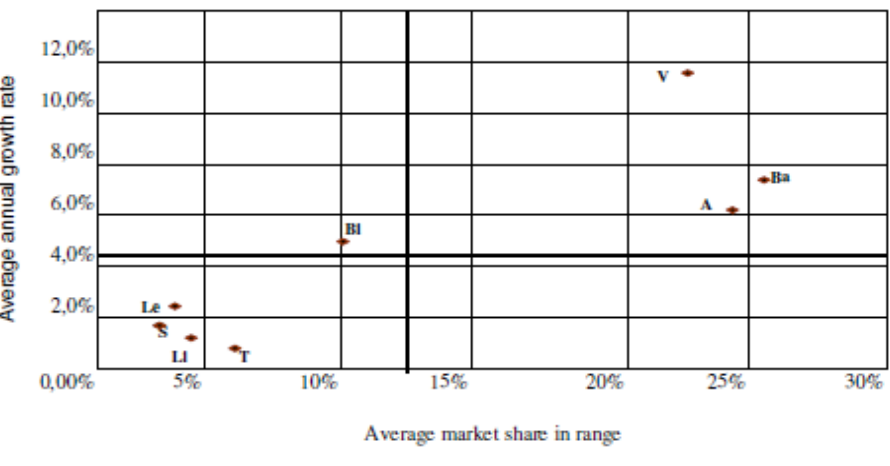
Figure 6: Portfolio of Iberian Peninsula seaports – Total traffic weight (1997-2008)